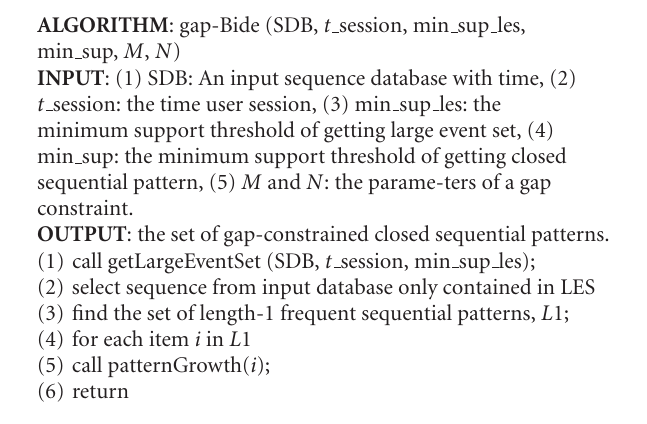
ALGORITHM : gap-Bide (SDB, t session, min sup les,